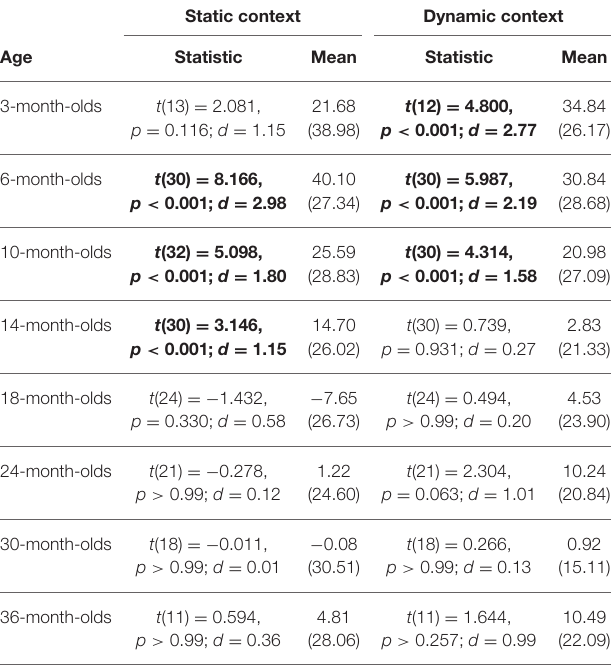
TABLE 4 | Statistics comparing attention to faces by age and